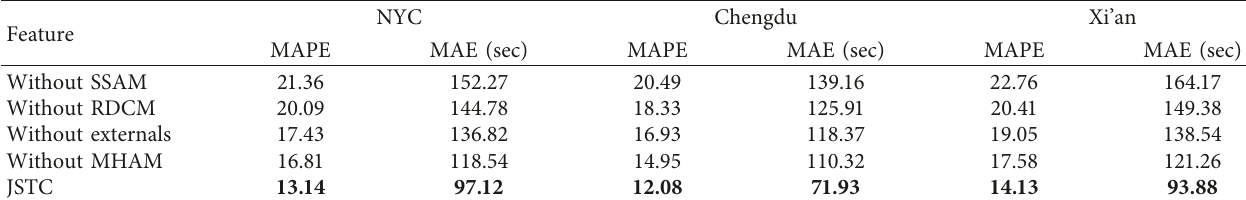
Table 6: Impact of the JSTC model’s components: SSAM, RDCM, MHAM, and external factors. Feature